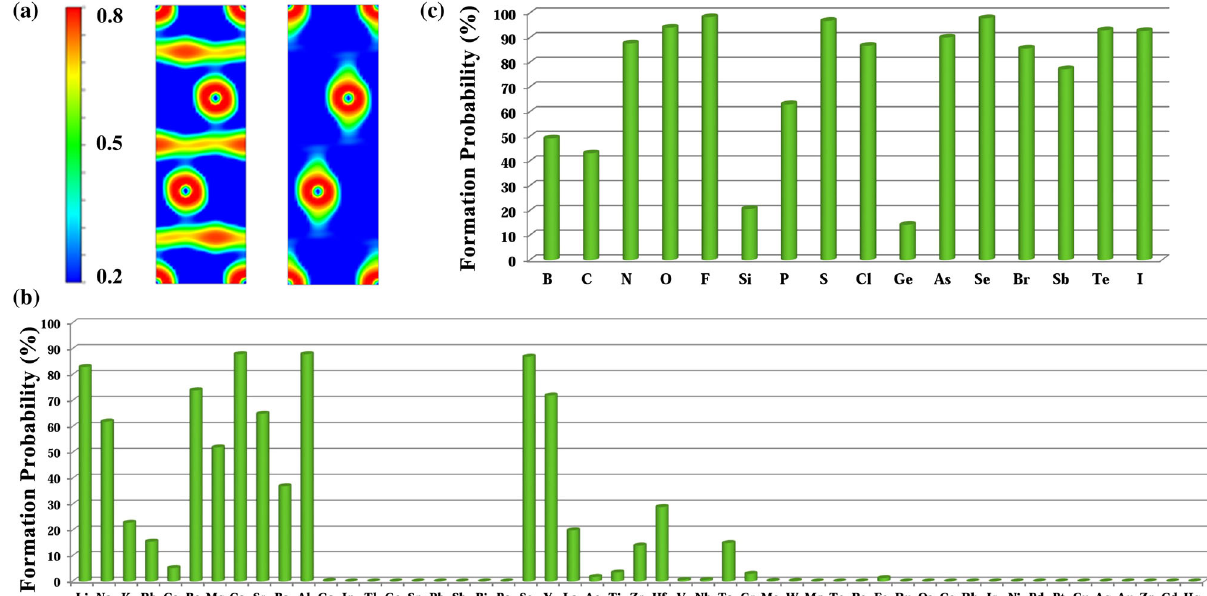
FIG. 3. Tests for the design principles. (a) ELF of Ca 2 N (left-hand panel) on the ð 110 Þ R plane parallel to the hexagonal c axis. Upon removal of one excess electron per Ca 2 N, the system loses electron localization (right-hand panel). Formation probabilities of electrides (ratios of electride phases to all structures generated by CALYPSO code in a simulation, characterizing the probability of the system to form electrides) in metal nitrides (b) and Ca 2 X compounds (c). Metal and X elements are listed on the x axis and the formation probabilities of electrides are shown on the y axis, respectively. The detailed testing metal nitrides and Ca 2 X compounds with their formation probabilities in (b) and (c) are listed in Tables S1 and S2 of Supplemental Material